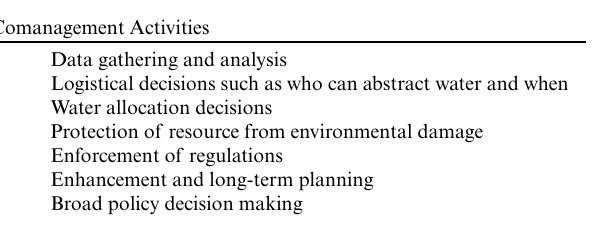
Table 1 . Seven comanagement activities. Adapted from (Pinkerton 1989 b